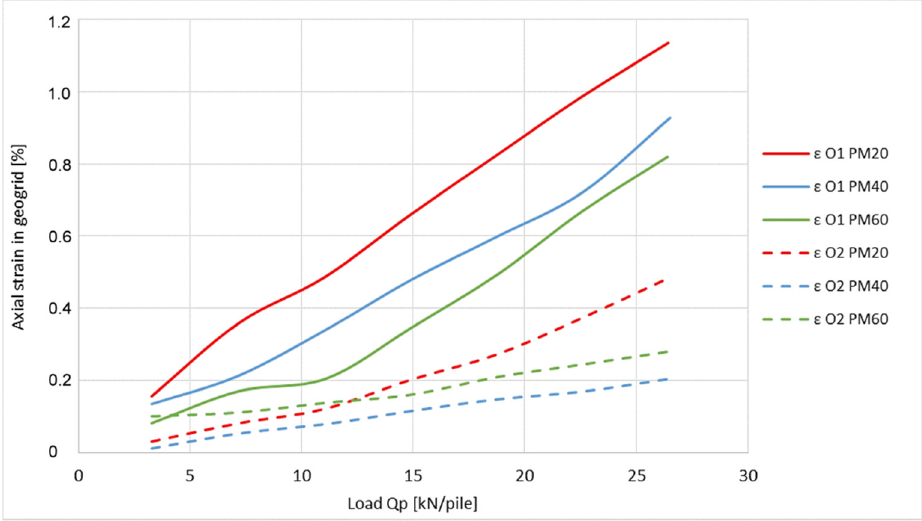
Figure 11. Comparison of the axial strains of the geogrid in locations O1 and